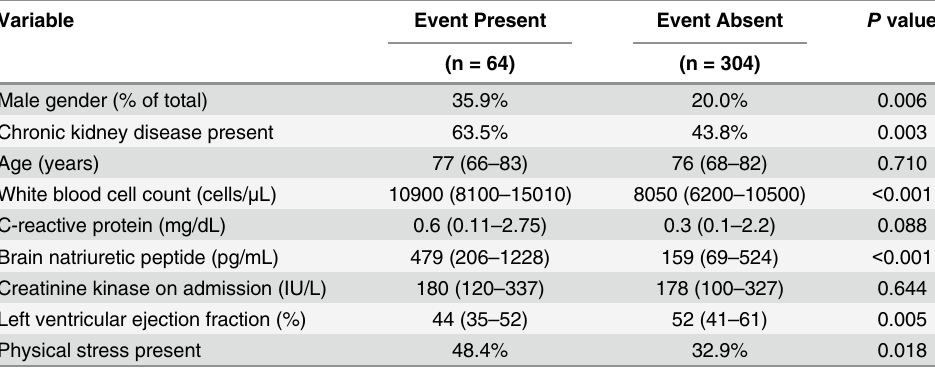
Table 3. Differences in clinical variables between patients with a composite cardiac event and those without an event.